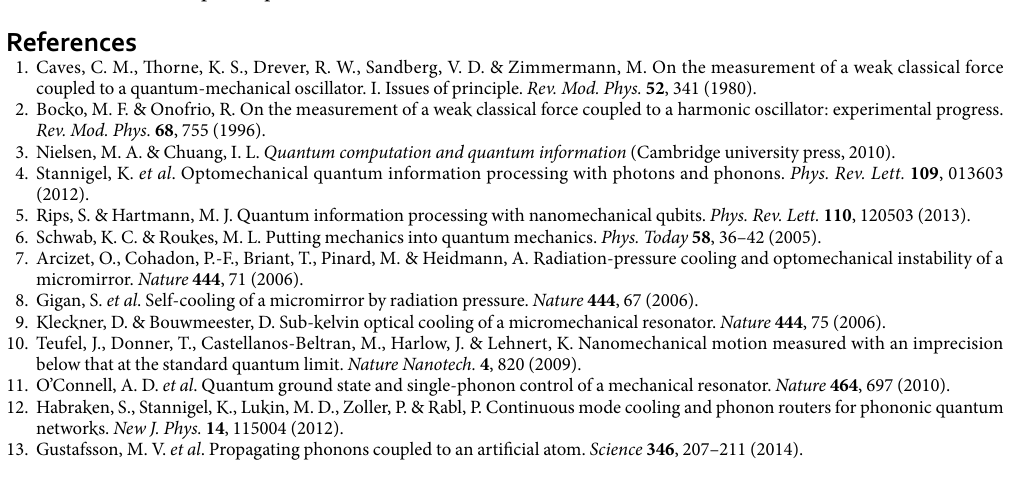
To obtain nontrivial solutions for C 11 , C 00 and C 02 , the determinant of the coefficient matrix must be zero, from where we obtain the optimal parameters.